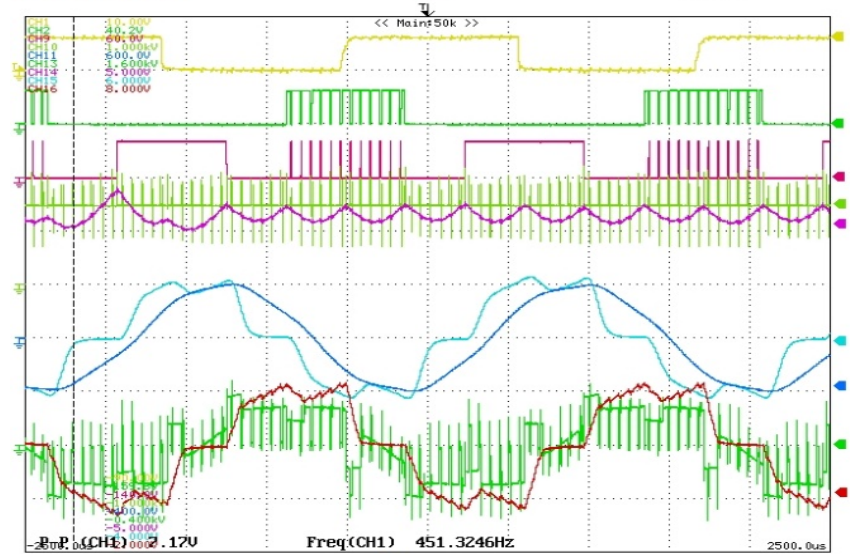
Figure 19. Phase currents, Phase voltages with lead angle adjustment at full load.